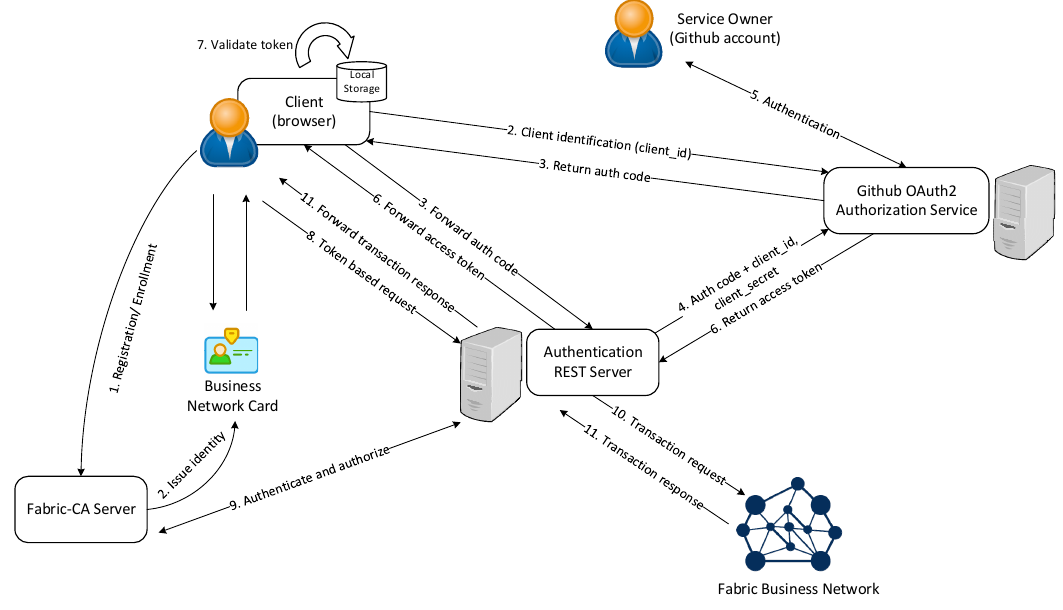
Figure 12. Github OAuth2.0 REST authentication overview.